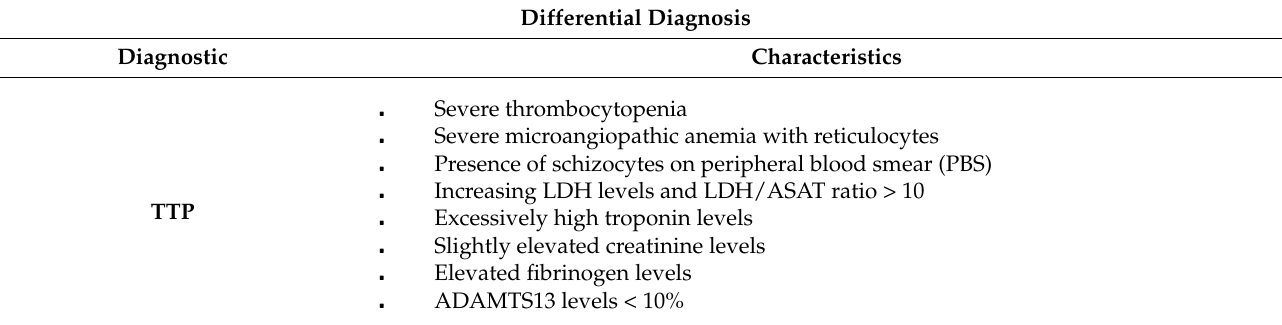
Table 1. Differential